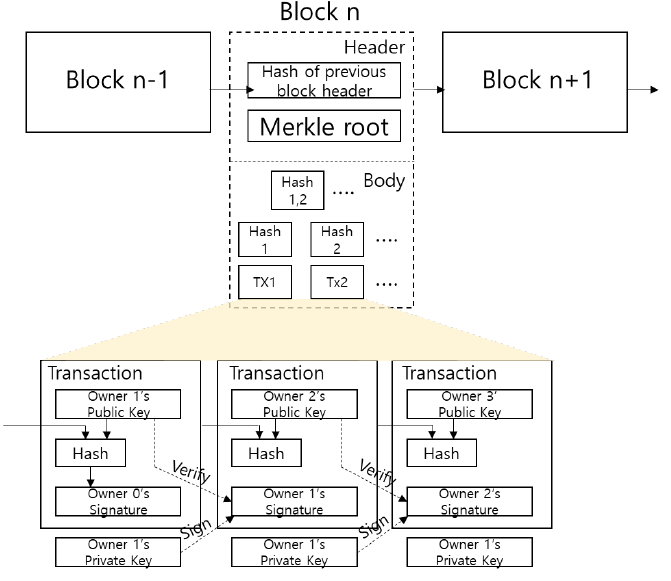
Figure 2. Structure of